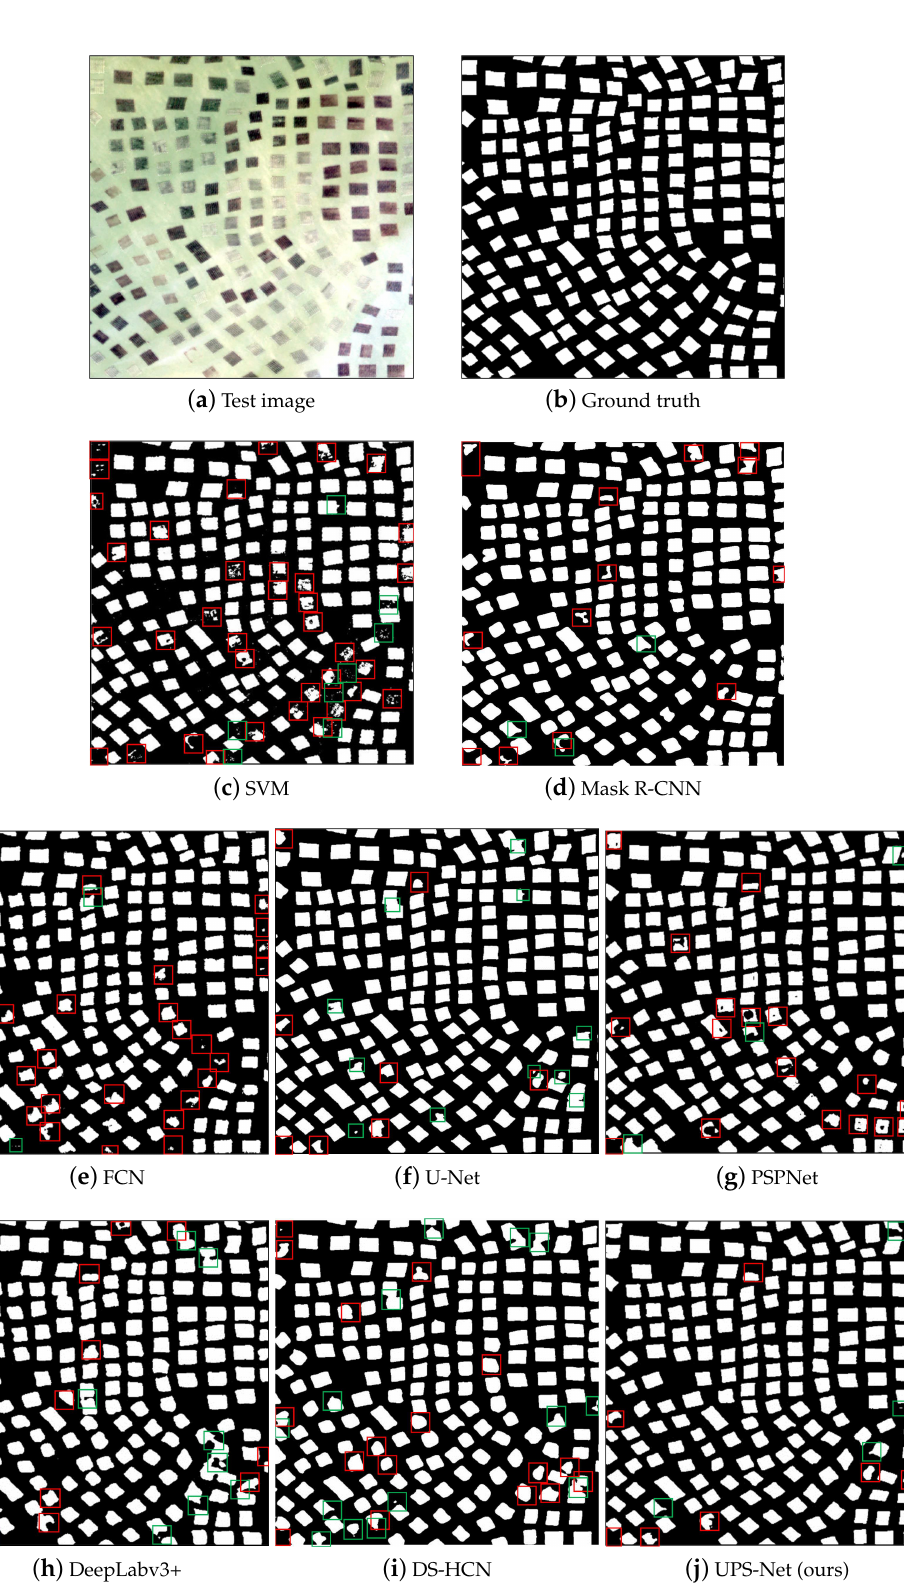
Figure 9. Extraction of raft aquaculture areas on the test image: ( a ) Test image; ( b ) Ground truth; ( c ) SVM; ( d ) Mask R-CNN; ( e ) FCN; ( f ) U-Net; ( g ) PSPNet; ( h ) DeepLabv3+; ( i ) DS-HCN; ( j ) UPS-Net. The red rectangles indicate raft aquaculture areas here were misrecognized as seawater, and the green rectangles indicate seawater areas here were misrecognized as raft aquaculture